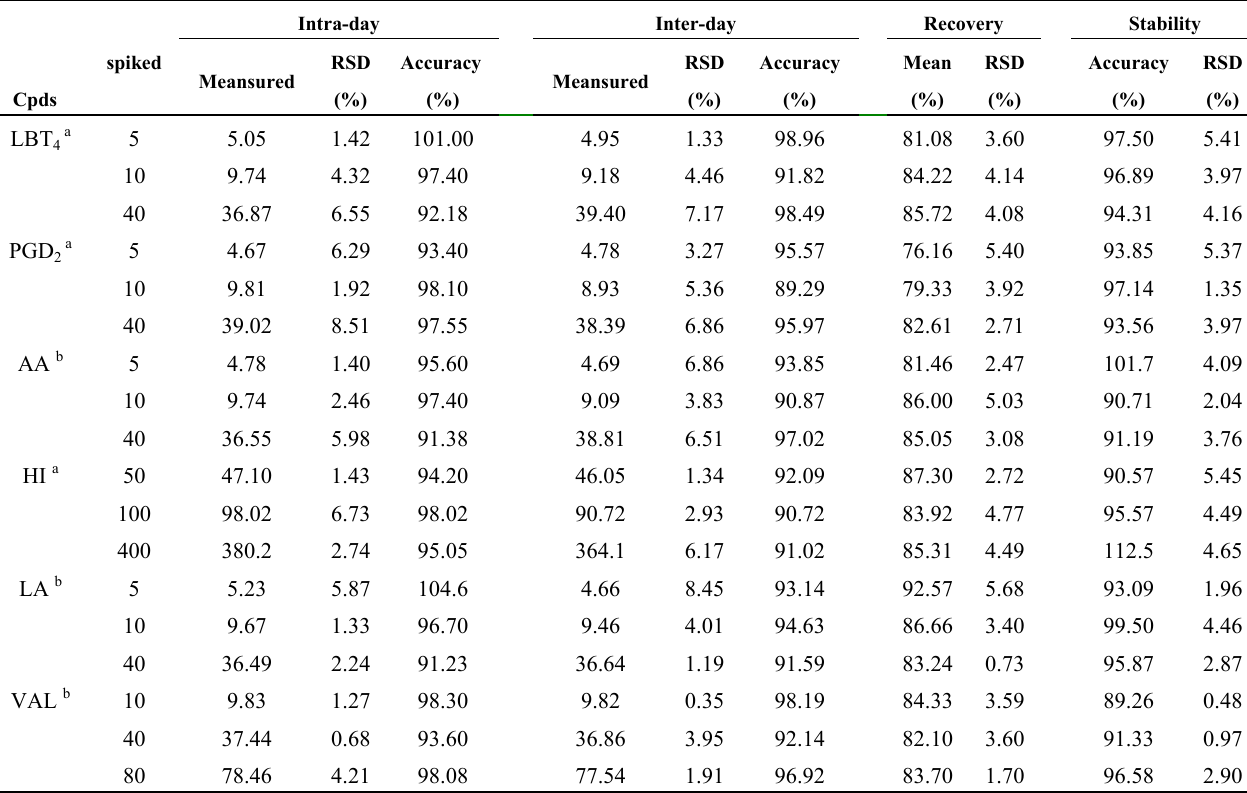
Table 2. Intra- and inter-day precision, accuracy, extraction recoveries and stability of the six compounds in rat serum (n =